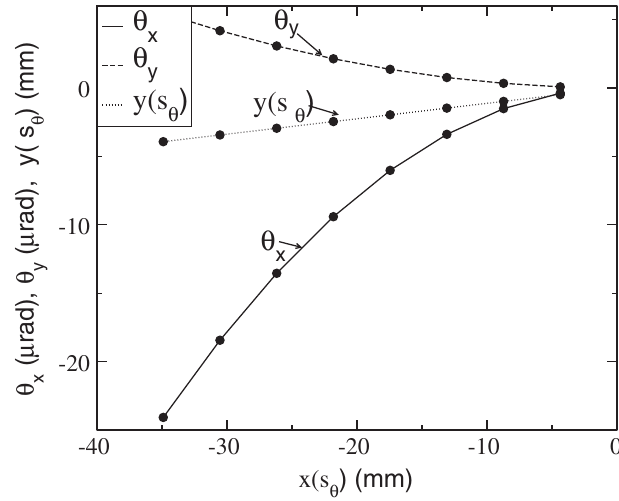
and vertical mag- x Þ is also (cid:1)